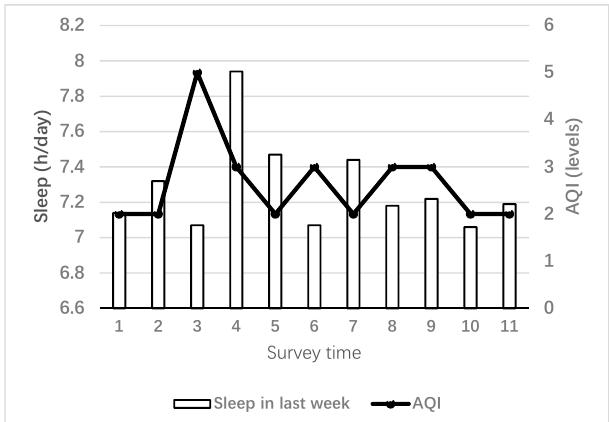
Figure 2. Trend for sleep in last week and air quality index (AQI) concentration among the freshman cohort. Survey time 1: 2013–2014 cohort (9–15 Dec); 2: 2013–2014 cohort (5–11 May); 3: 2014–2015